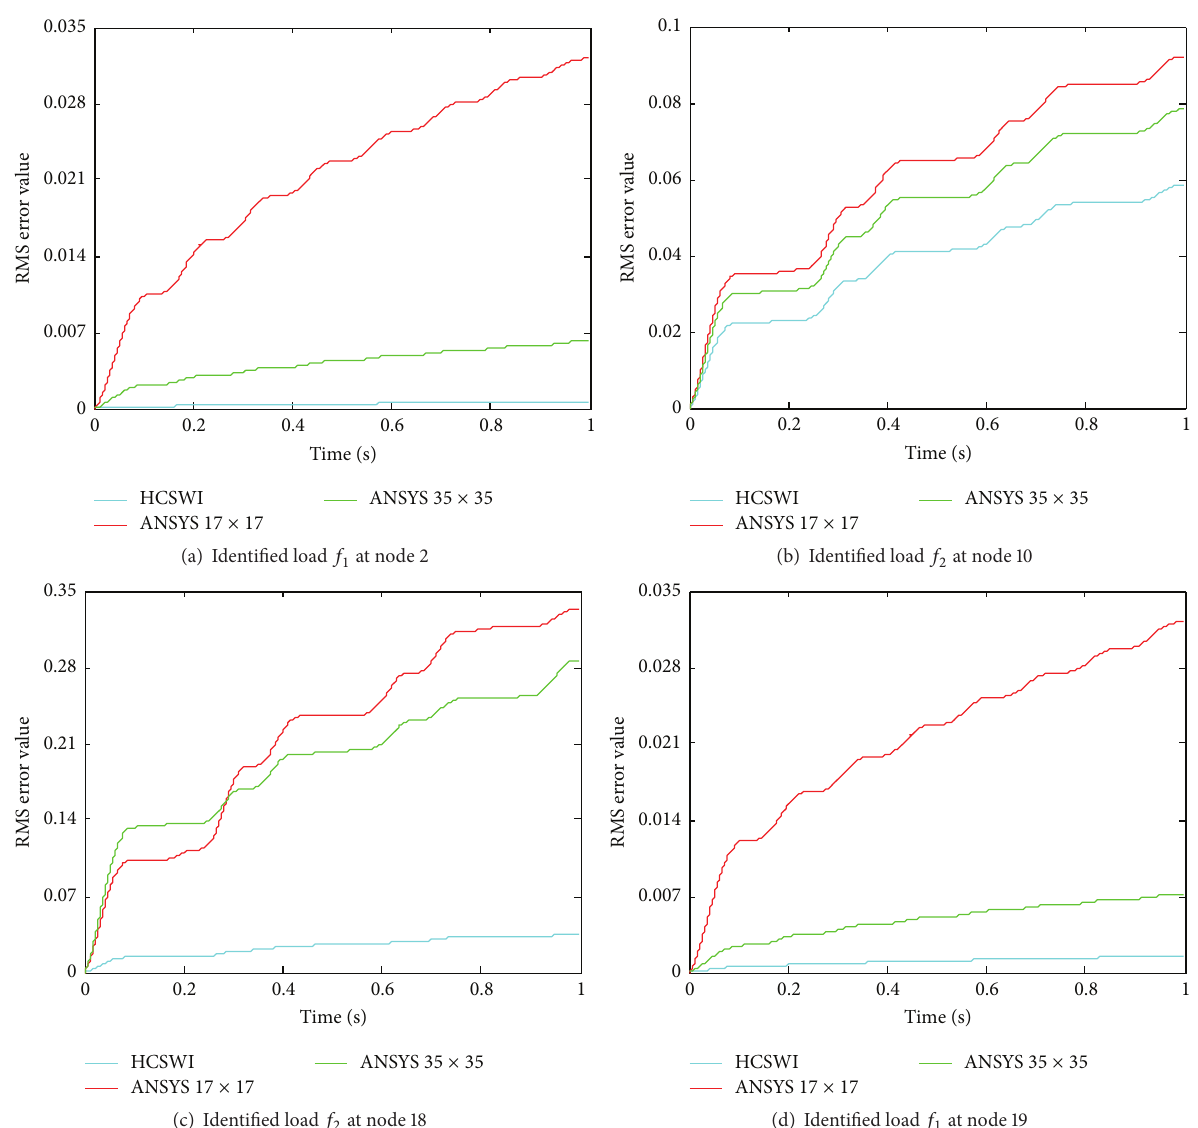
Figure 15: The root mean square error value with excitation 𝑓 1 and excitation 𝑓 2 applied at nodes 1 and 9.